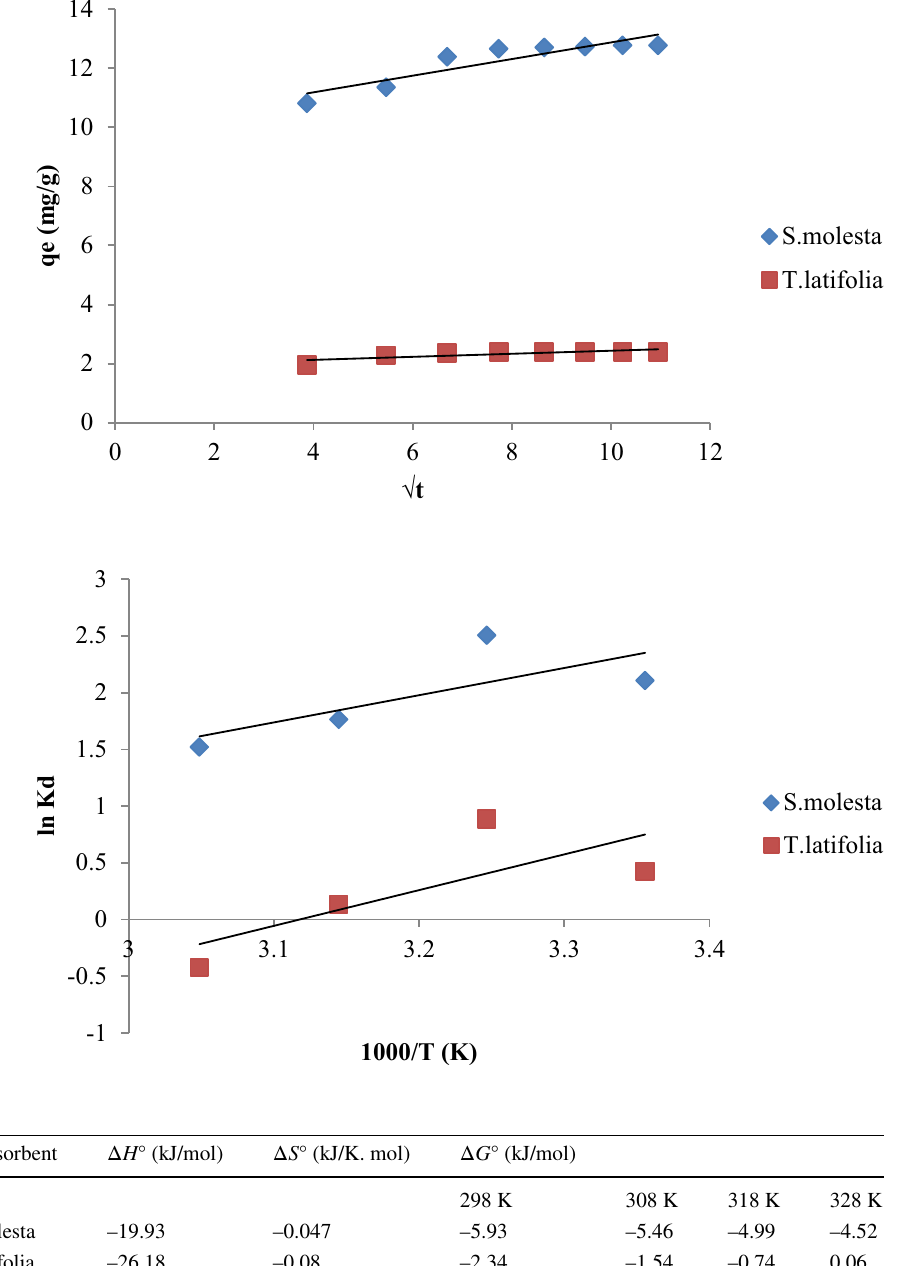
is spontaneous at low temperature and non-spontaneous at a higher temperature. It was observed that the adsorption process was exothermic and spontaneous.